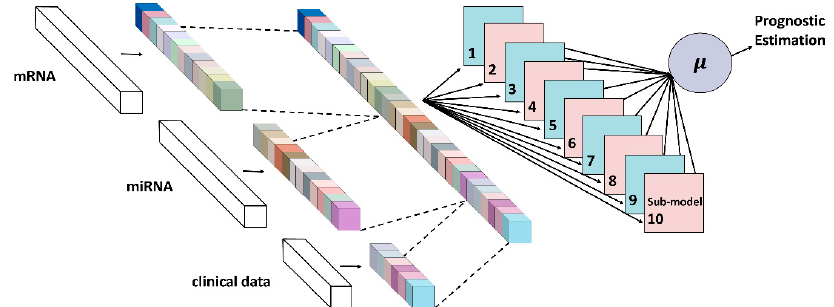
Figure 1. The deep learning architecture of Multi-PEN. The second layers with colors indicate the gene attention layers. The data multiplied by the attention values are transferred to sub-models. The estimation is the average value of each model.